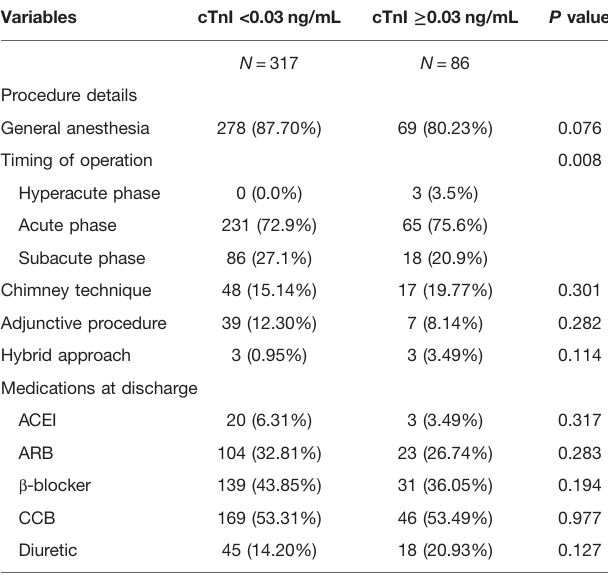
TABLE 3 | Endovascular procedure and antihypertensive drugs strati fi ed with cTnI <0.03 ng/mL and ≥ 0.03 ng/mL Variables